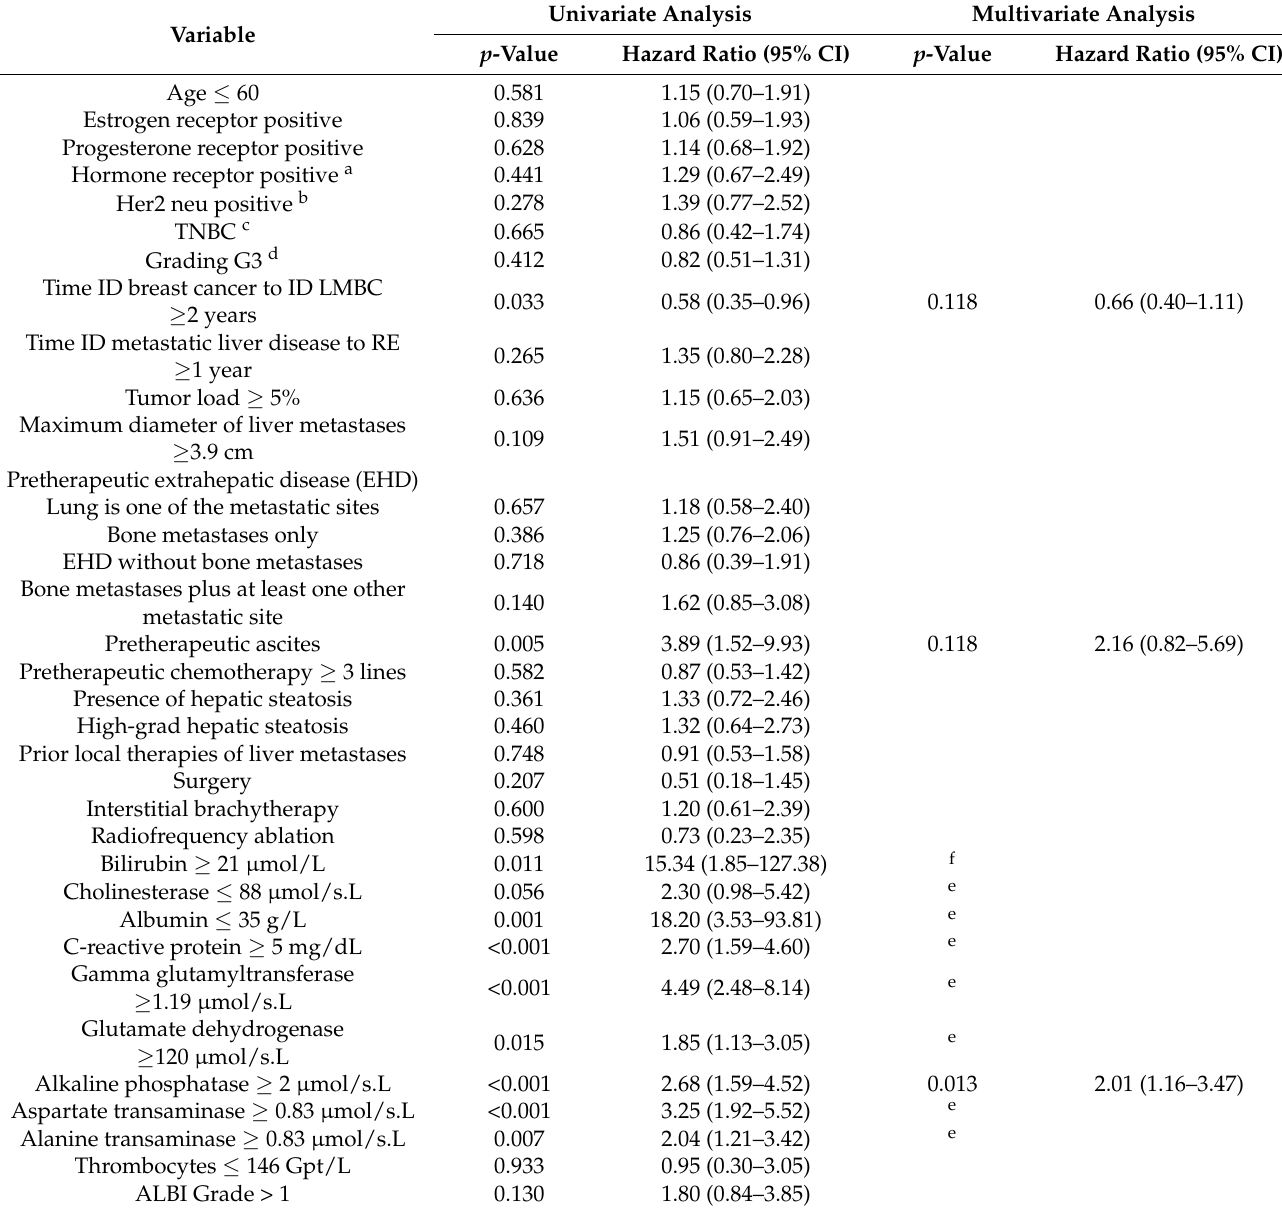
Table 4. Univariate and multivariate Cox regression analysis for overall survival following radioembolization. Univariate Analysis Multivariate